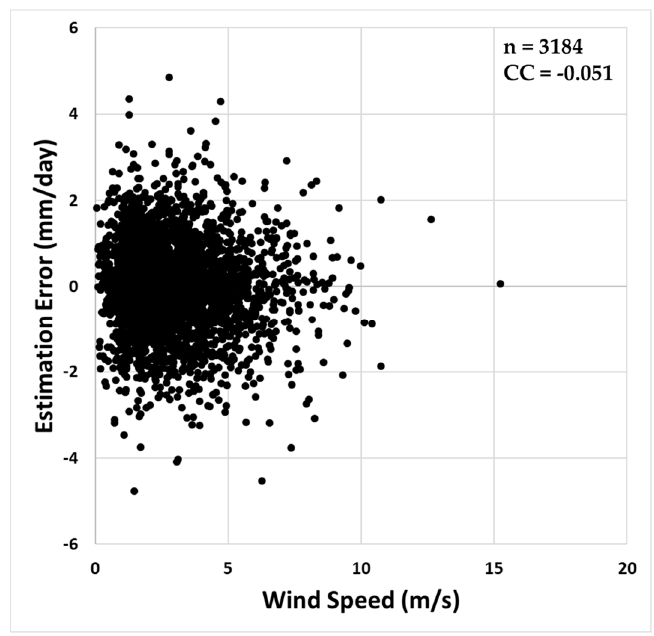
Figure 7. Relationships between wind speed and the estimation error of ET 0 . No correlation was found between them.